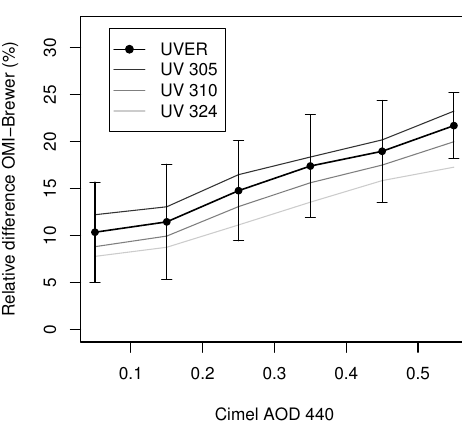
Fig. 4. Dependence of the relative difference between OMI and Brewer for UVER with respect to OMI solar zenith angle (SZA).